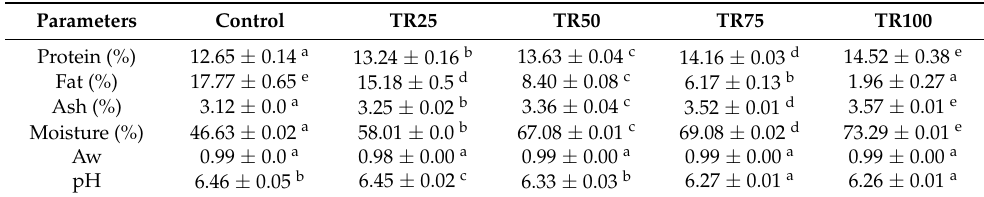
Table 2. The proximate composition expressed in wet base, water activity and pH of sausages with pork fat replaced by tremella.